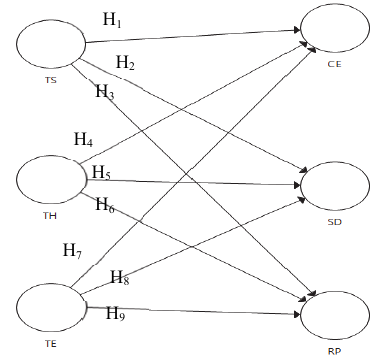
Fig. 1. Conceptual model and